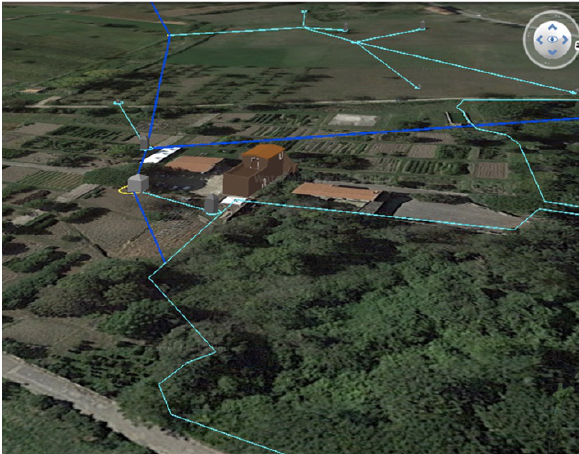
Figure 11 . ‘Carolino’ Aqueduct. WebGIS system (Credit: Vincenzo